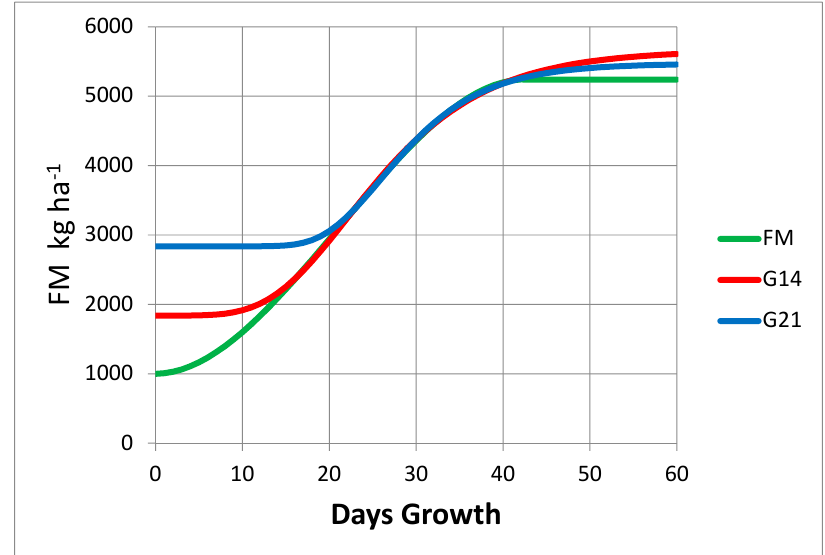
Figure 2. The Gompertz non-linear growth model always calculates an initial slow growth phase. This becomes a systematic error when there is no slow growth phase. The forage mass (FM) line represents the ‘true’ growth rate for a theoretical pasture. The Gompertz model, evaluated over days 14 to 43 (G14) and days 21 to 43 (G21), predicted zero growth at an FM of 1900 and 2900 kg DM ha − 1 , respectively, while the ‘true’ growth had a low growth rate at an FM of 1000 kg DM ha − 1